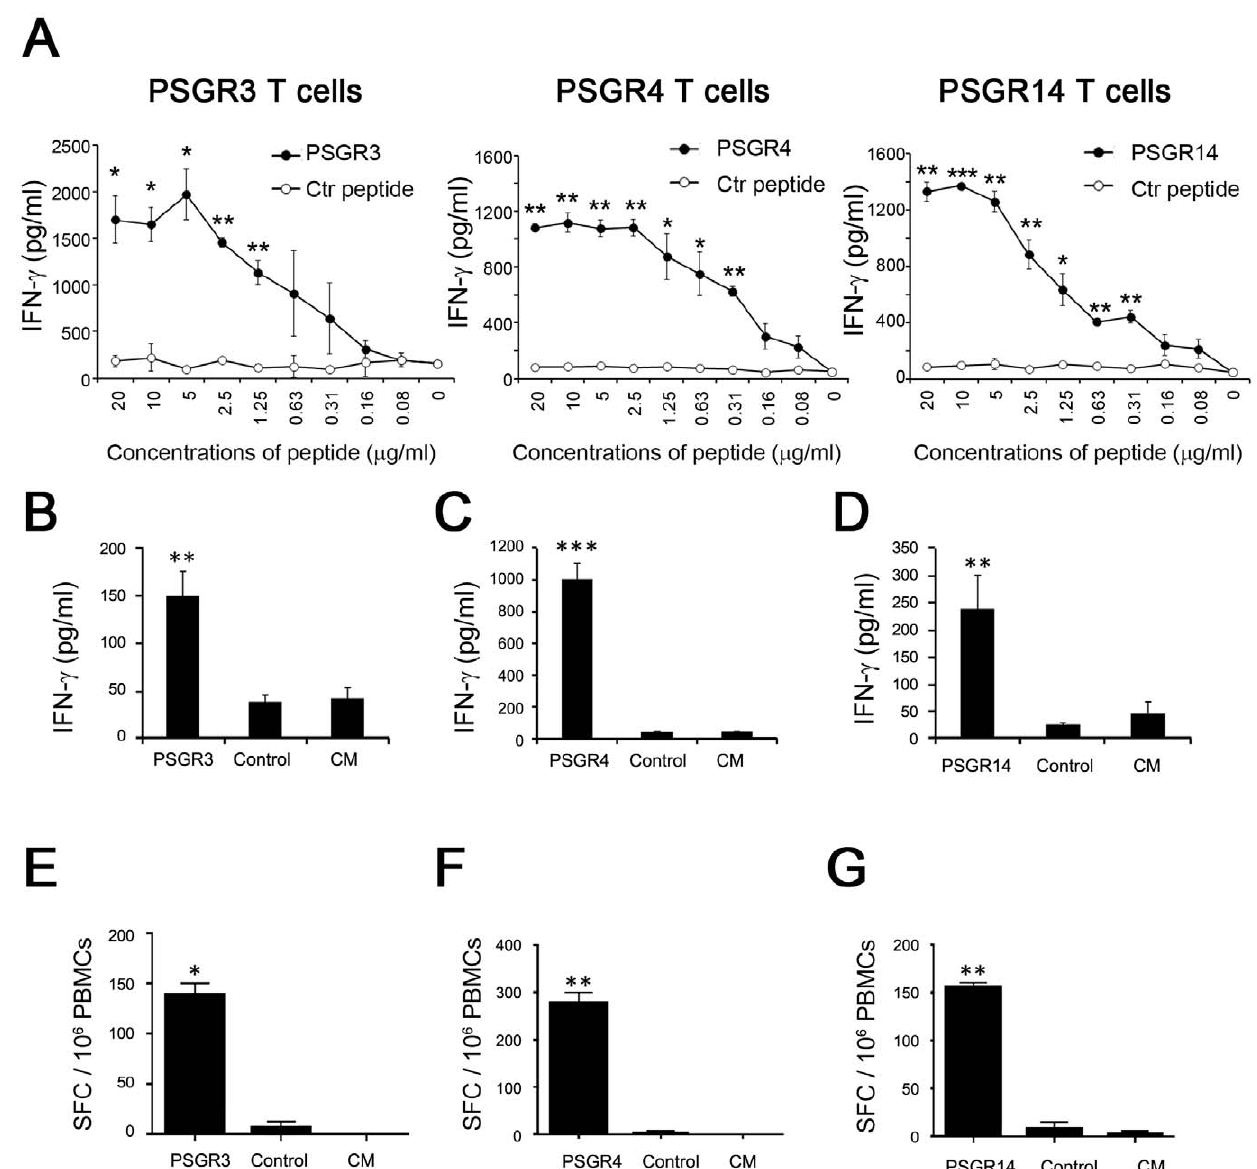
Figure 1. PSGR-derived peptides induced peptide-specific T cells. The recognition of T2 cells pre-loaded with titrated concentrations of peptides (0–20 m g/ml) by expanded PSGR peptide-specific T cells was tested by ELISA assay (A). The expanded PSGR3 T cells (B and E), PSGR4 T cells (C and F) and PSGR14 T cells (D and G) were respectively co-incubated with T2 cells (1 6 10 4 cells/well) alone in complete medium (CM), or with T2 cells pre-loaded with either a corresponding peptide (5 m g/mL) or a control peptide as a negative control. Cells were incubated for 18 2 24 hours, the IFN- c secretion in the supernatant was determined by ELISA assay (B, C and D). IFN- c spot-forming cells (SFC) were enumerated by ELISPOT assay (E, F and G). Data are plotted as means 6 SD. Results are representative of at least three independent experiments. * P , 0.05, ** P , 0.01, *** P , 0.001 versus controls (T2 cells alone or T2 cells pulsed with a control peptide). doi:10.1371/journal.pone.0045756.g001 prostate cancer cells, we used an HLA-A2 negative PC3 cell line and an HLA-A2 positive LNCaP prostate cancer cell line. The expression of PSGR in these two cell lines was examined by RT- PCR. Consistent with a previous report [31], PSGR was highly expressed in LNCaP, but not in PC3, DU145 or a normal prostate cell line PNT1A (Figure 2 A). As shown in Figure 2B, PSGR3-, PSGR4-, or PSGR14-specific T cells from both healthy donors and patients could recognize and kill HLA-A2 positive, PSGR expressing LNCaP, but not HLA-A2 negative PC3 cells. These